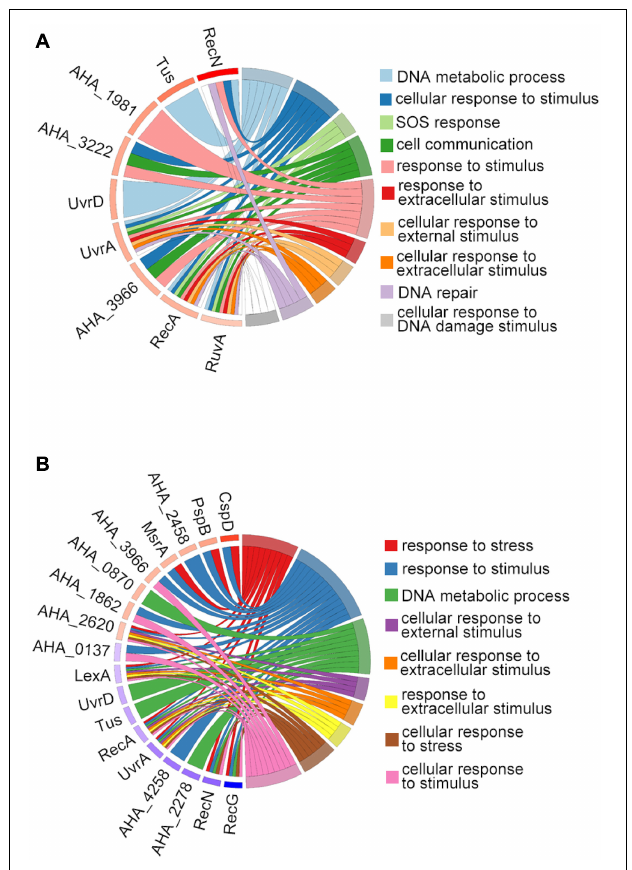
FIGURE 3 | Chord plot showing GO terms BP analysis of differentially expressed proteins in the two comparisons. (A) (cid:49) ahslyA + ENX vs. WT + ENX, and (B) (cid:49) ahslyA + ENX vs. (cid:49) ahslyA